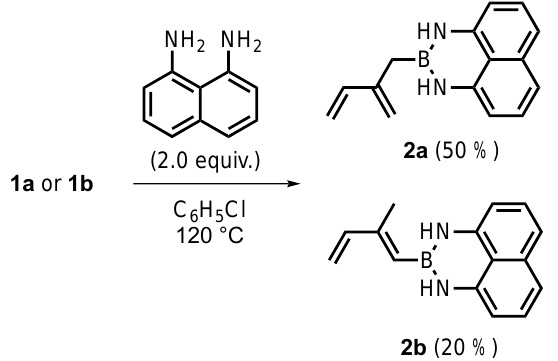
Scheme 2. Synthesis of boron diamide comonomers 2a and 2b .